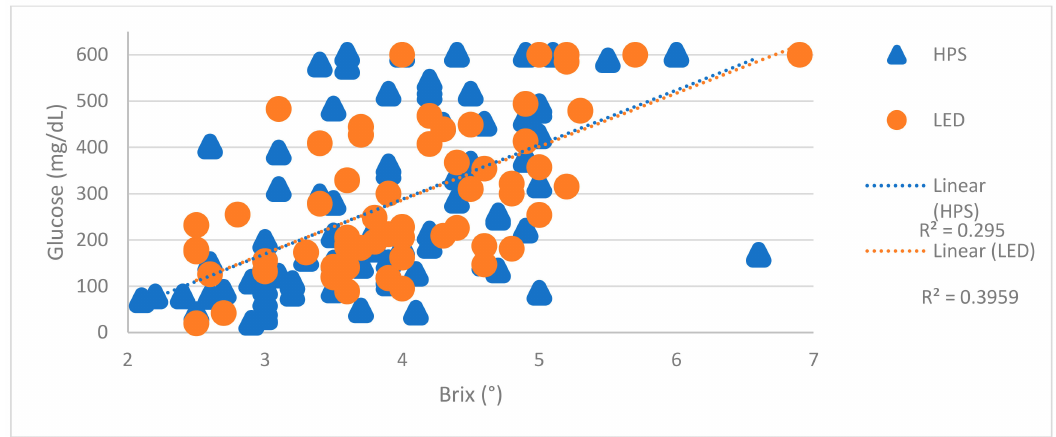
Figure 1. Recorded glucose responses graphed against recorded brix values. Data are raw responses of individual plants that were read for both brix and glucose. Orange dots represent LED-grown plants, and blue triangles represent HPS-grown plants. Linear regression lines are